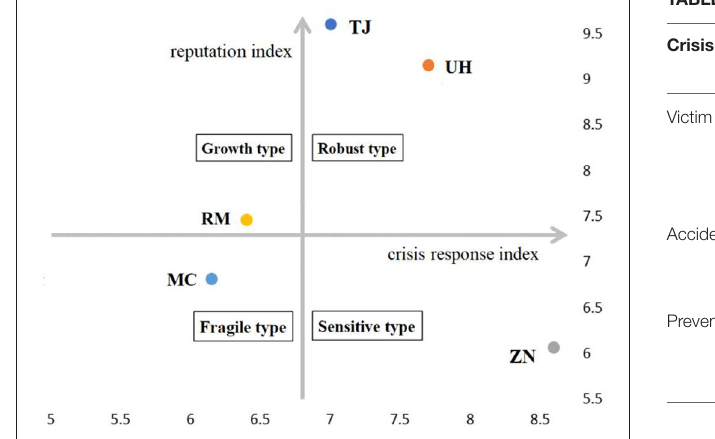
FIGURE 2 | Coordinate chart of the MHI reputation crisis management index.